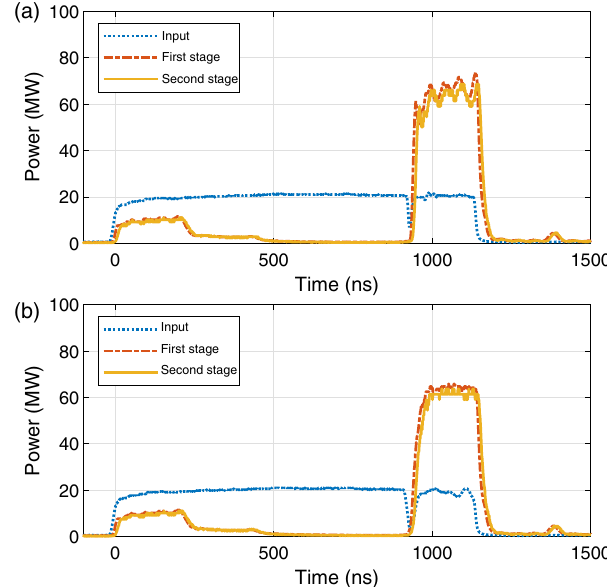
FIG. 16. Waveforms of the pulse compression system (a) with and (b) without amplitude modification when the second-stage storage cavity was